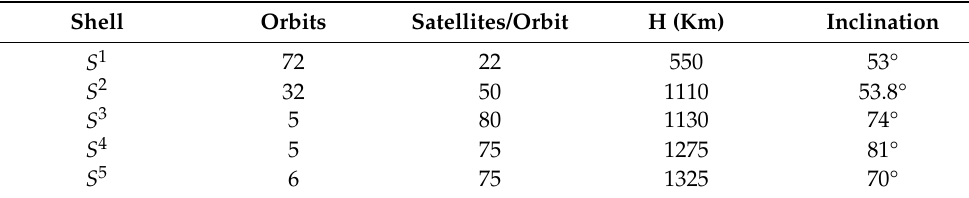
Table 1. Shells configuration for the first phase of StarLink constellation